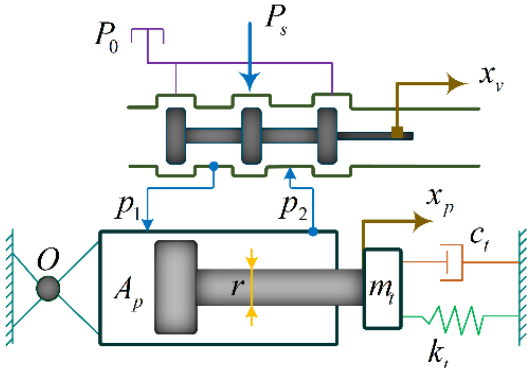
Figure 6. The hydraulic system with the lateral AHC for ESR.